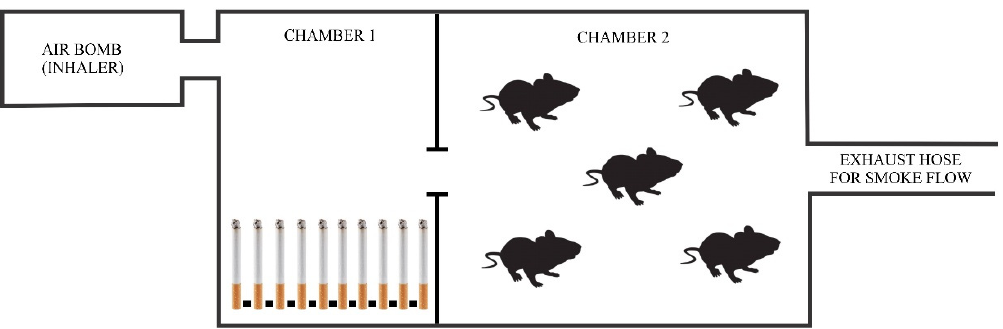
Figure 1. Schematic drawing representing the smoke exposure mechanism. The cigarettes were placed in chamber 1 and the rats remained in chamber 2 during the period of exposure to cigarette smoke.